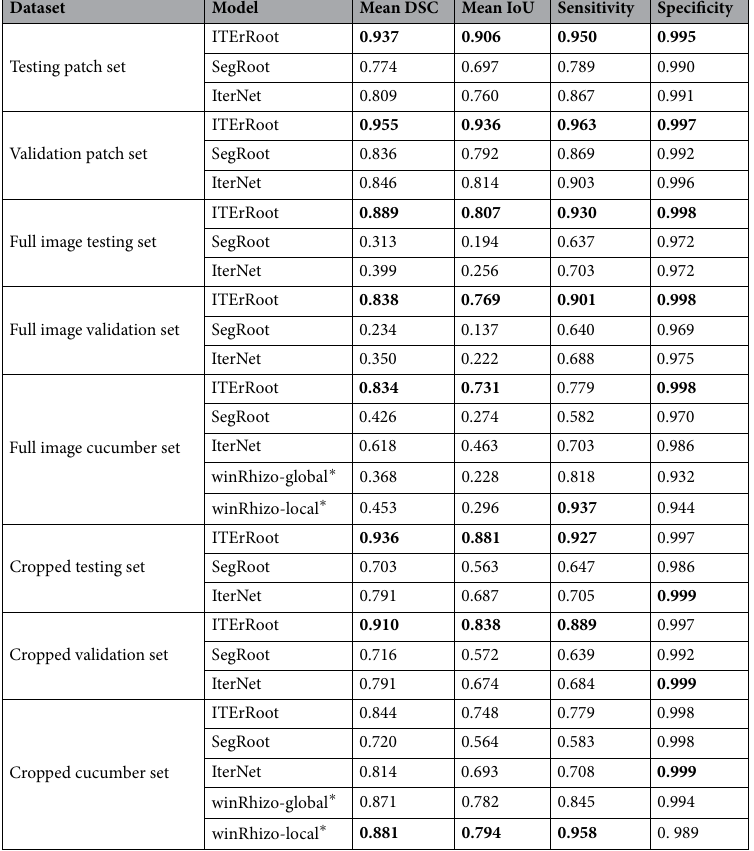
Table 7. Comparison with other models on each dataset. Bold values indicate the best result obtained for each combination of dataset and setmentation quality metric. All models trained on the training set used in trial 2. ∗ For the Full Image Cucumber Set and the Cropped Cucumber Set, we include threshold-based segmentation with winRhizo. Results are shown for both global and local thresholding (see in "Comparison to segmentation withwinRhizo"